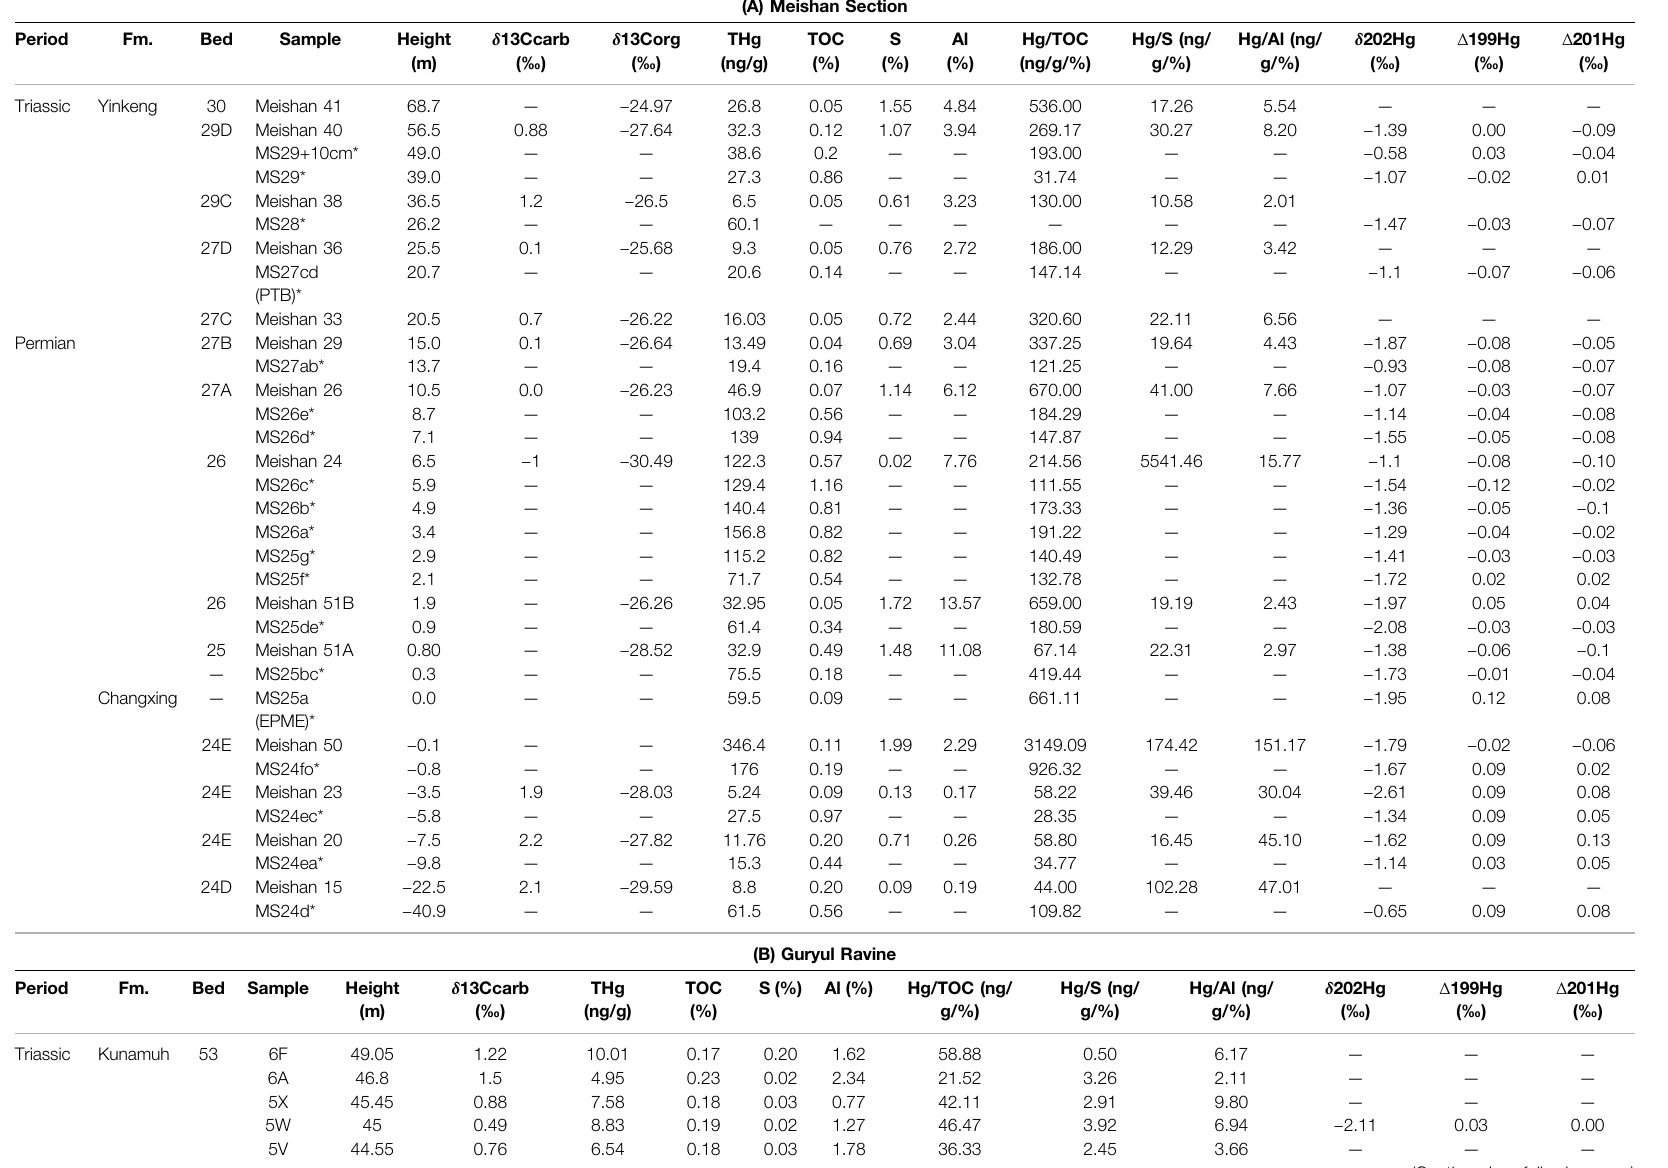
(A) Meishan Section